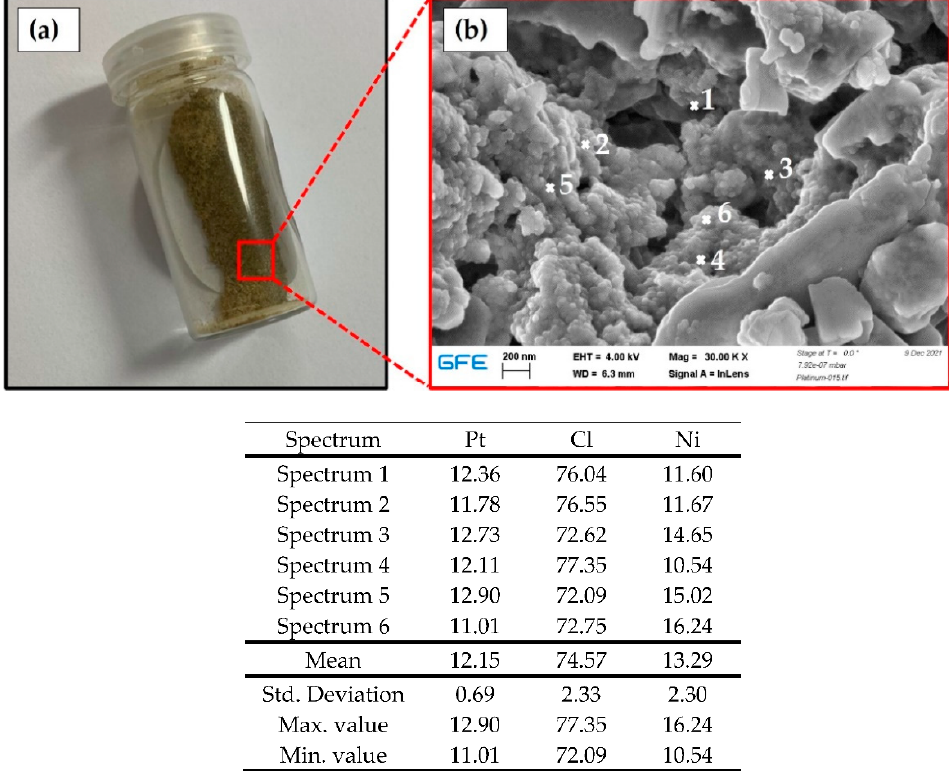
Figure 7. Insoluble precipitate: ( a ) Macro-view and ( b ) SEM microstructure showing places for EDS analysis.